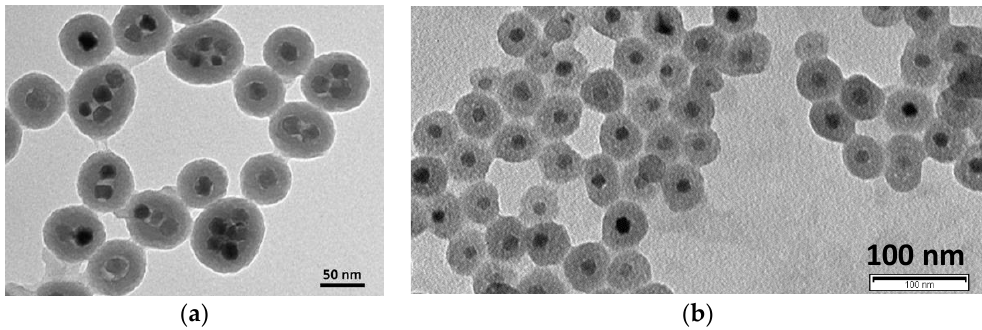
Figure 12. TEM micrographs of silica coated magnetite NPs by ( a ) Stöber processes, which generally result in multi-core coated NPs and ( b ) microemulsion processes, which provide mainly single core-shell NPs.